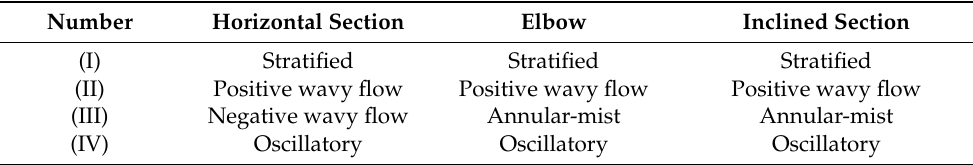
Figure 9. Flow pattern map: ( a ) for increasing the gas flow rate, ( b ) for decreasing the gas flow rate (Minami et al. [66]). Table 5. Correspondence of flow patterns to the numbers shown in Figure 9 (Minami et al. [66]).